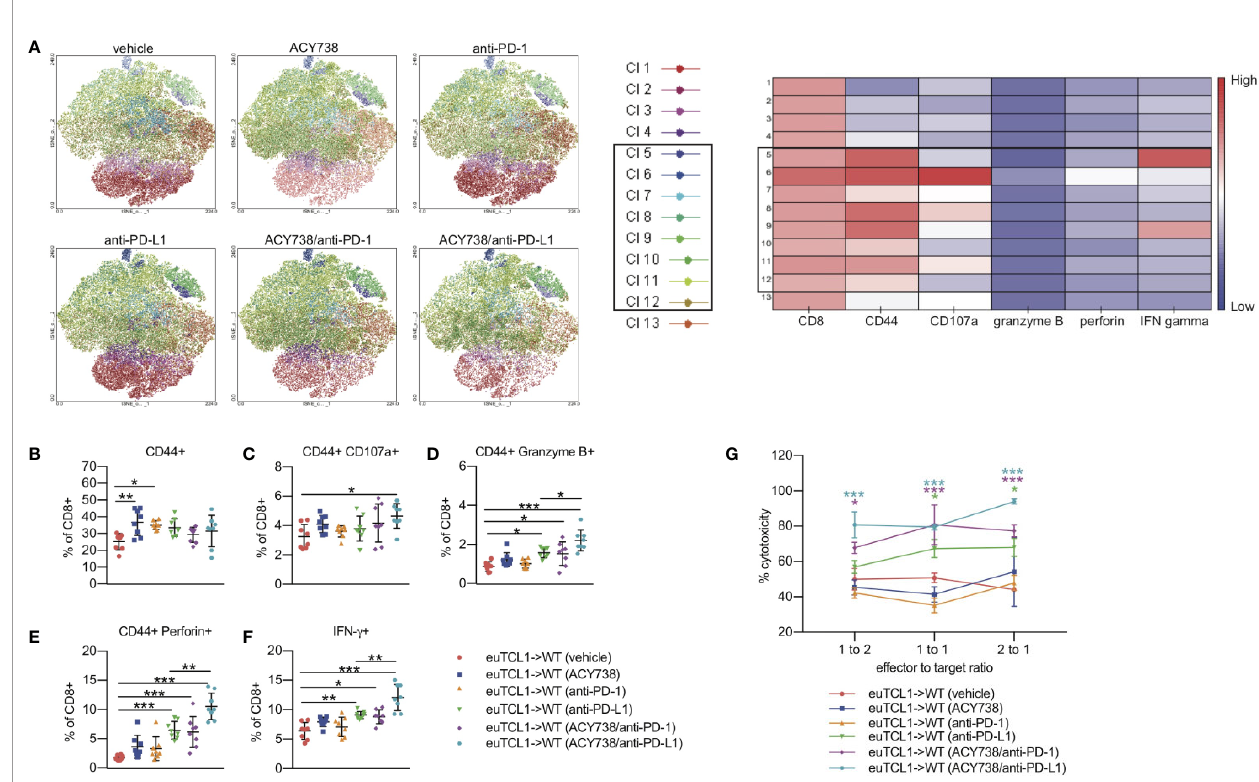
FIGURE 6 | Combination of ACY738 and PD-1/PD-L1 blockade enhances cytotoxic CLL T-cell response. (A – F) Mice treated as in Figure 4 were sacri fi ced at week 7 post-adoptive transfer and splenocytes were stimulated with PMA/ionomycin in the presence of GolgiStop for 4 h. Cytotoxic cellular proteins were detected by fl ow cytometry. (A) Unbiased clustering analysis by tSNE. Xshift analysis was performed to determine clusters of cells based on differential expression of markers. (B) Antigen-experienced CD44 + fraction out of CD8 + T cells. (C – F) Percent positive for indicated cytotoxic markers out of antigen-experienced CD8 + CD44 + fraction. n = 6 – 8 mice per group. (G) Europium-release cytotoxicity assay. CD8 + effector T cells were incubated with CD19 + ligand-loaded target B cells for 4 h. Fluorescence was quanti fi ed to detect ligand released into supernatant by dead target cells. % lysis is expressed normalized to positive control wells containing target cells treated with lysis buffer, and background fl uorescence was subtracted using negative control wells containing viable, ligand-loaded target cells only. n = 4 mice per group. Comparisons indicated in (G) are versus vehicle group. Graphs display mean + SD. * p < 0.05, ** p < 0.005, *** p < 0.0005. Cl, cluster.